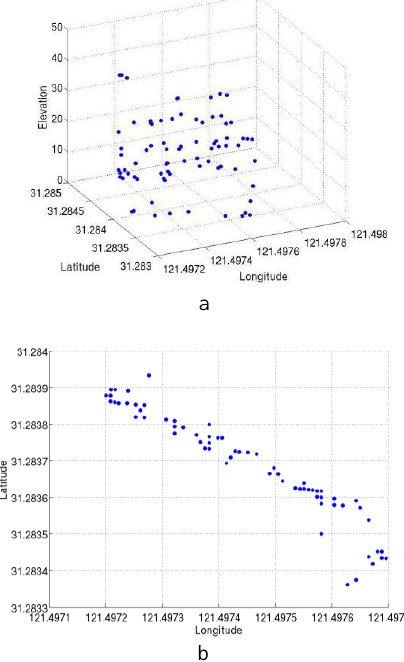
Figure 8. 3D model (a) and horizontal position (b) of PS points